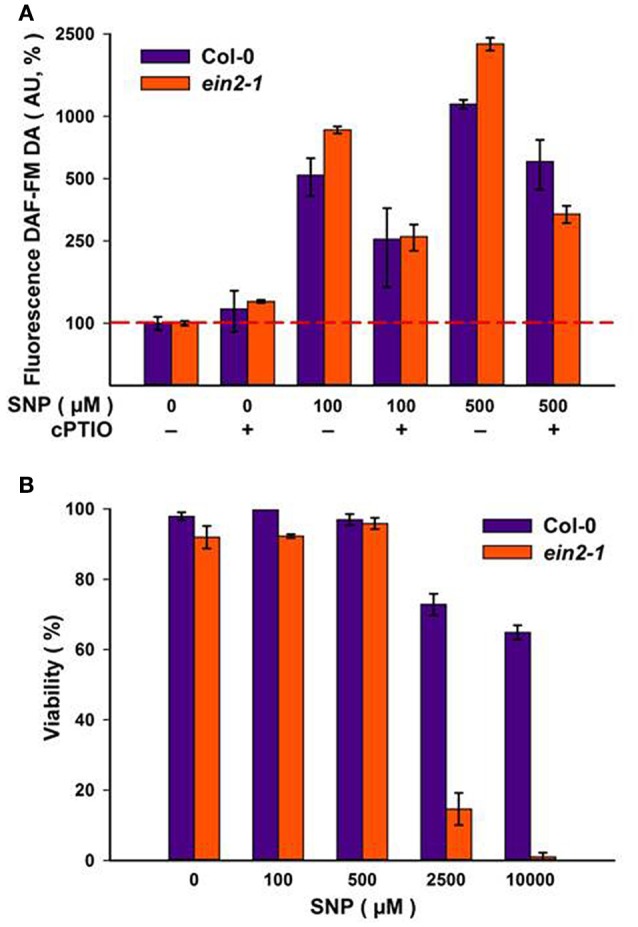
Levels of NO as detected by DAF-FM DA fluorescence at the day four of sub-cultivation of Col-0 and ein2-1 cells after 3-h treatment with sodium nitroprusside (SNP). The specificity of the fluorescent signal is demonstrated by parallel treatments with 100 μM of the NO scavenger cPTIO (A). Cell viability was detected using Erythrosin B (B). On (A), the ordinate axis is represented on a log scale. Values are expressed as mean ± SE of biological triplicates with five analytical replicates.